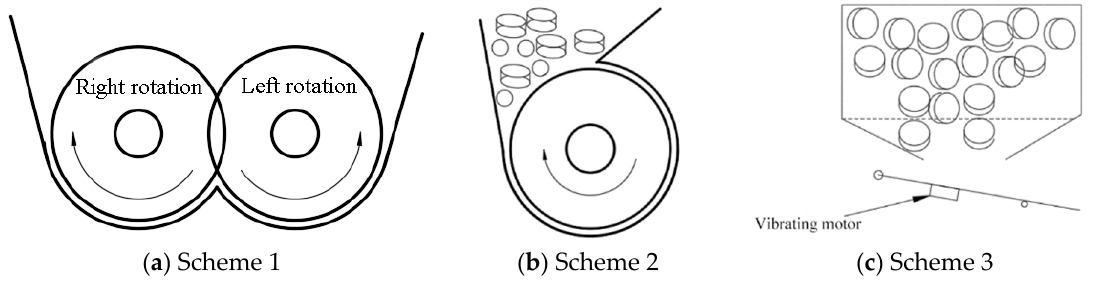
Figure 12. Improved design scheme.